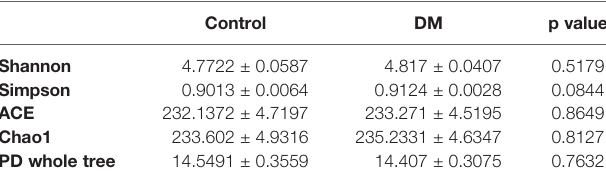
TABLE 2 | Alpha Diversity